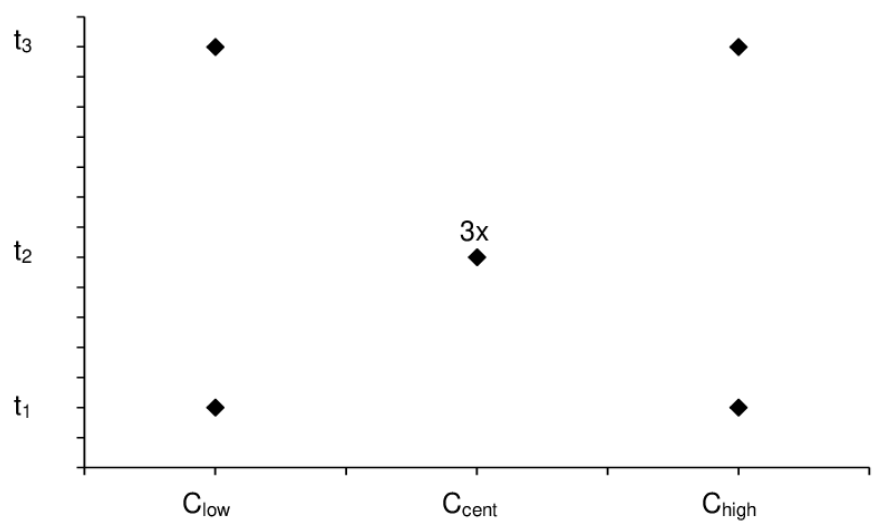
Table 1. The experimental boundaries in this work.